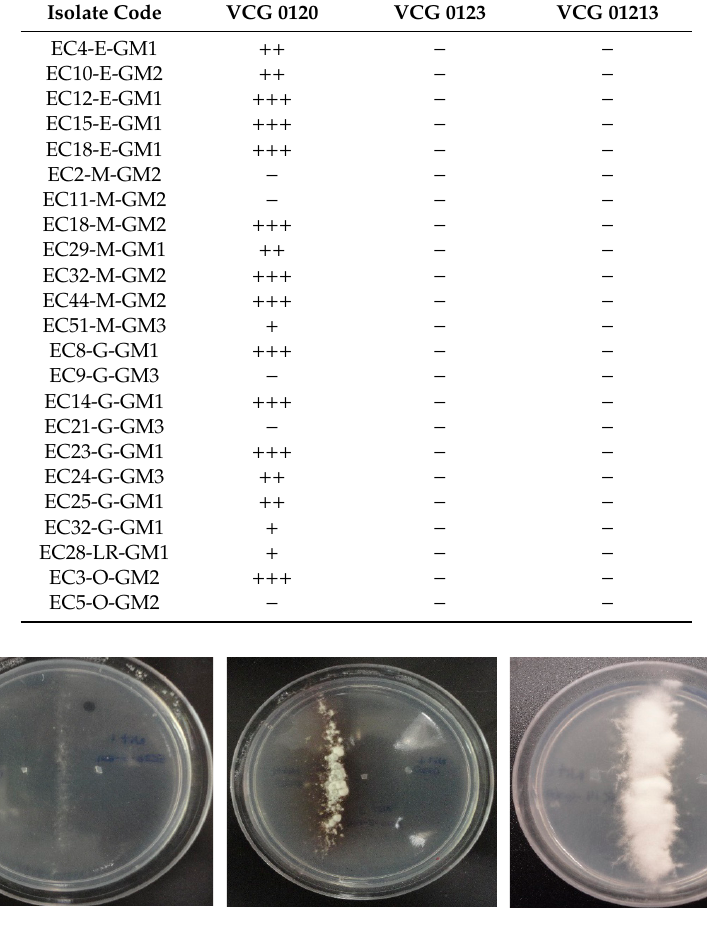
Figure 5. Categorical illustration of the di ff erent heterokaryon formation during compatibility tests using Nit -mutants: Weak compatibility ( left figure ), moderate compatibility ( central figure ), strong compatibility ( right figure